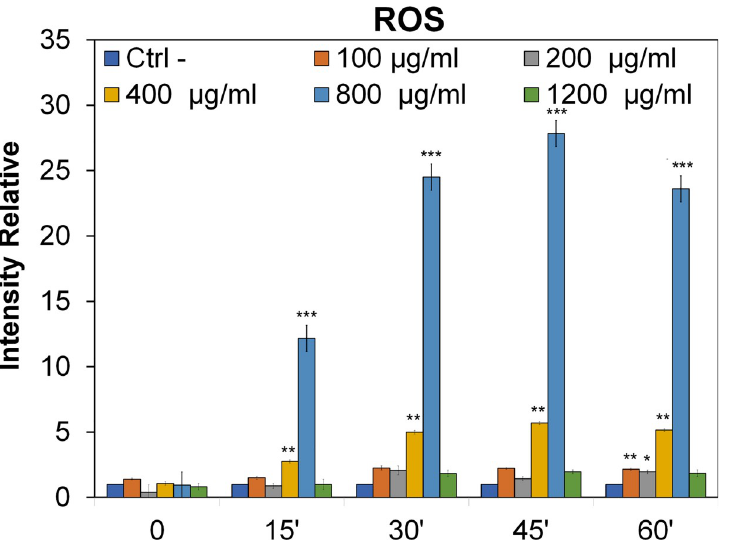
Fig 5. ROS production in HCT116 cell line. The ROS production after exposure at different concentrations and time (100 μ g/mL, 200 μ g/ml, 400 μ g/mL, 800 μ g/mL and 1200 μ g/mL concentrations and at 0,15,30,45 and 60 min time) of Polystyrene Nanoparticles on HCT116 cells. Each time refers to T0. Hydrogen peroxide (H 2 O 2 ) was used as a positive control (value not reported in the Figure). Significant values � = p < 0.05; �� = p < 0.005; ��� p = < 0.0005; error bars represent the standard error of the